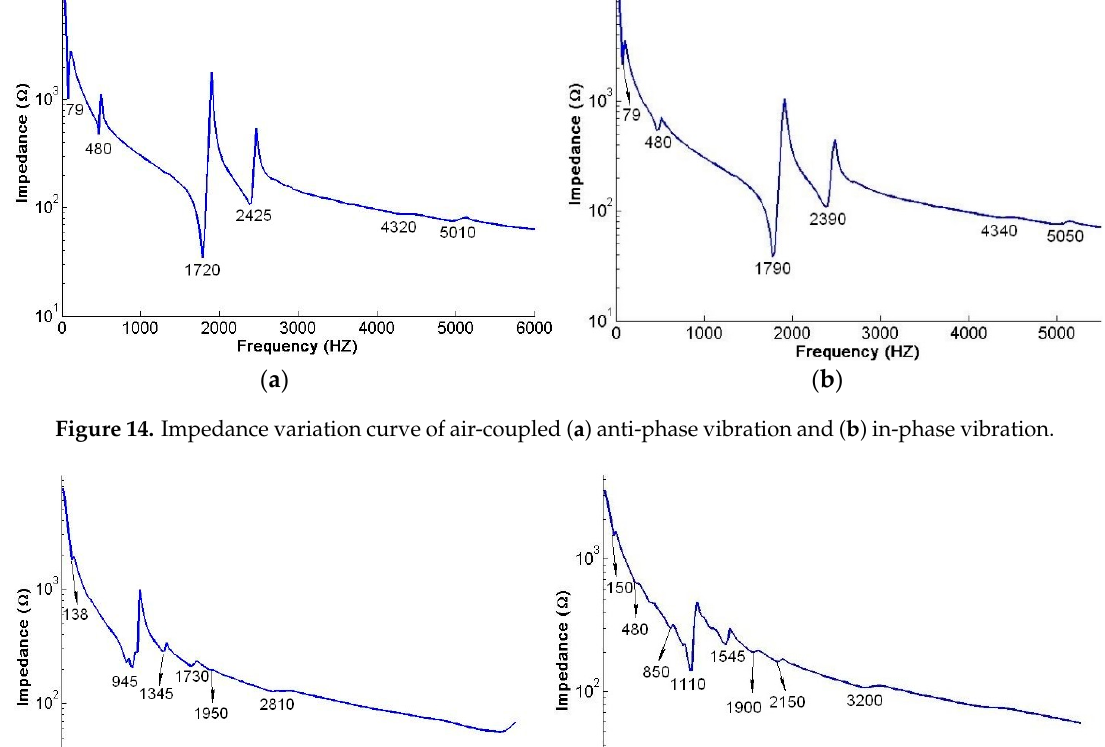
Figure 16. Impedance variation curve of glycerine-coupled ( a ) anti-phase vibration and ( b ) in-phase vibration.